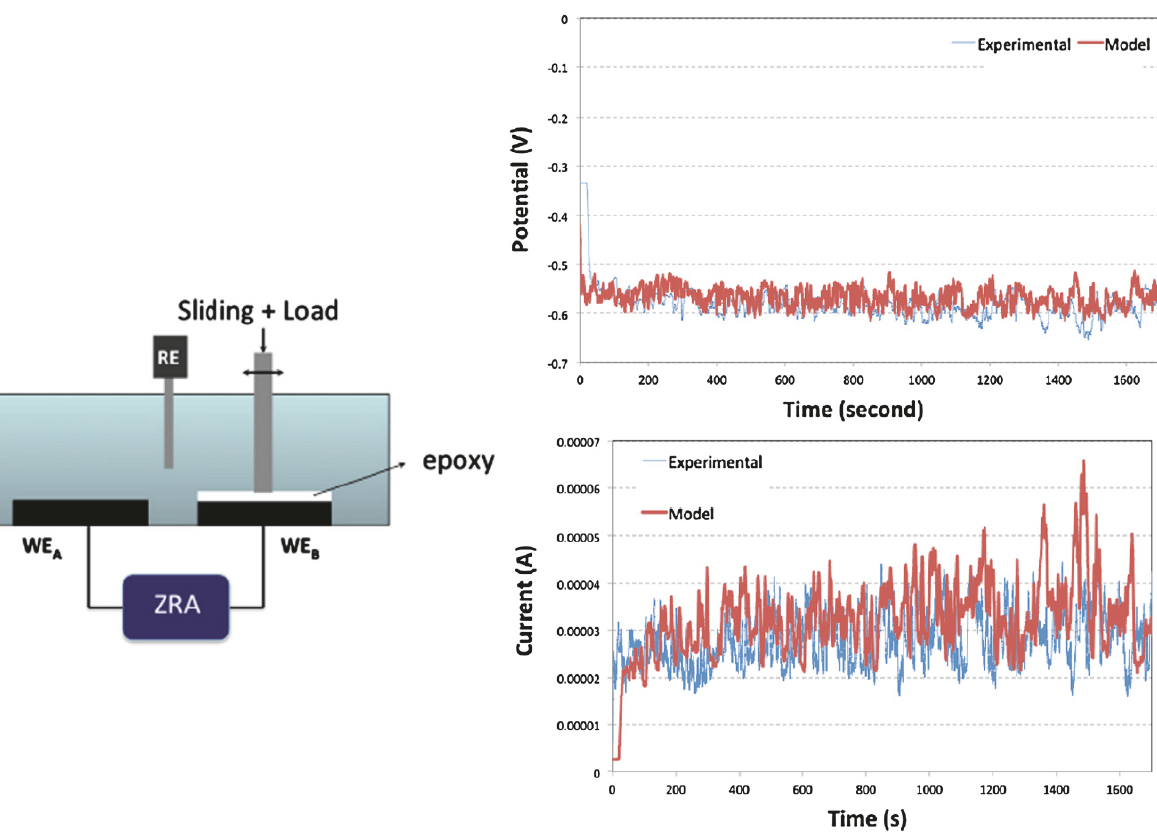
Figure 13: Left: schematic of the electrochemical setup used by Espallargas et al. [97] connecting the uncoated sample (unworn surface) and coated sample (wear track) through a ZRA. Right: potential and current evolution for a Ti6Al4V rubbed against an Al 2 O 3 ball at 540 MPa in artificial saliva, obtained by Licausi et al. [98] using this setup. The experimental results and the simulated values.